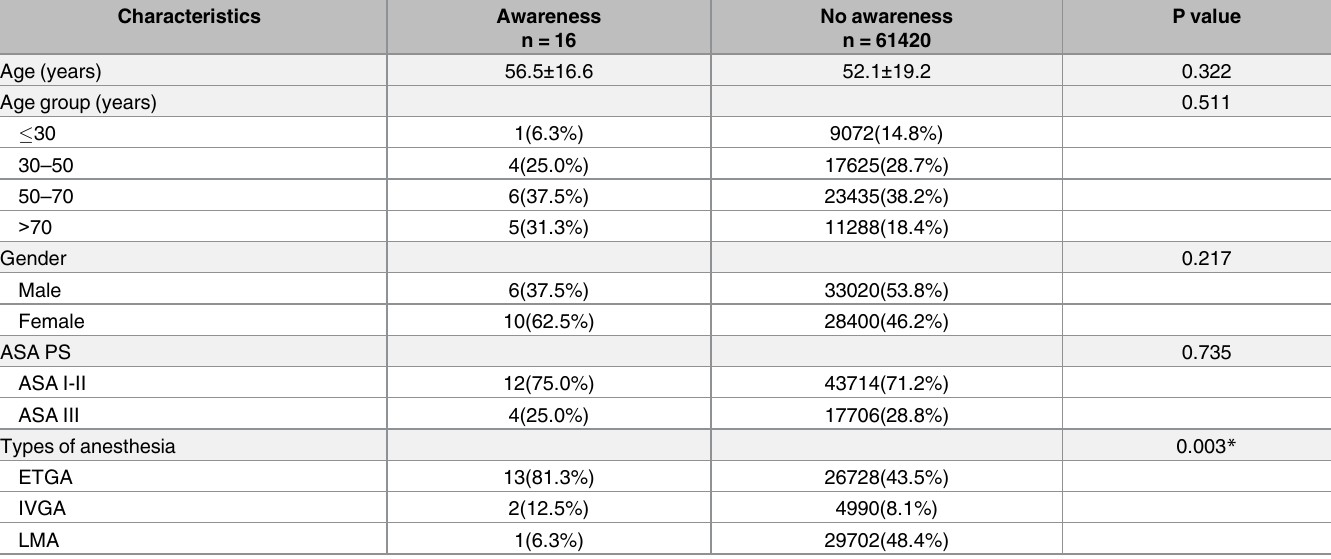
Table 2. Characteristic analysis of intraoperative awareness in at-risk